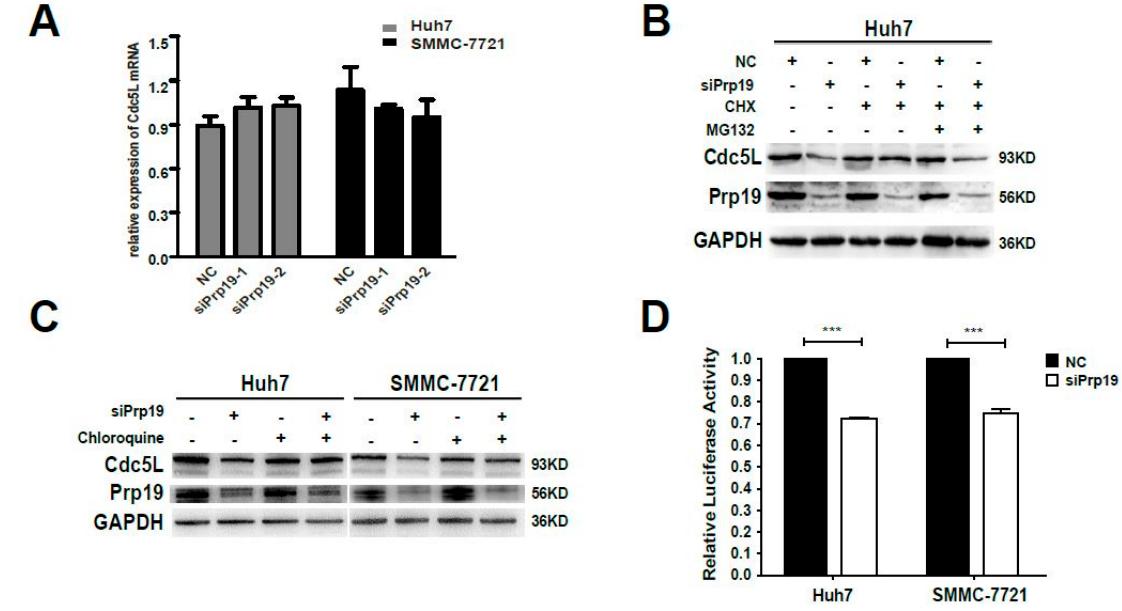
Figure 3. Prp19 modulates Cdc5L expression via inhibiting mRNA translation and facilitating lysosome-mediated degradation in HCC cells. ( A ) The mRNA levels of Cdc5L were measured by qPCR in HCC cells treated with siPrp19 or control siRNA; ( B ) Huh7 cells were transfected with indicated siRNAs. After 48 h transfection, Huh7 cells were treated sequentially with 100 μ g/mL CHX for 1 h, 20 μ M MG132 for another 6 h, and followed by western blot; ( C ) Huh7 and SMMC-7721 cells were transfected with siPrp19. After 48 h transfection, these cells were treated with 25 μ M Chloroquine for another 12 h, and followed by western blot; ( D ) Huh7 and SMMC-7721 cells were transfected with indicated siRNAs. After 24 h transfection, they were co-transfected with control reporter pRL-TK vector and pGL3-5 ′ UTR-Cdc5L for another 48 h, and then luciferase activity was measured (*** p <